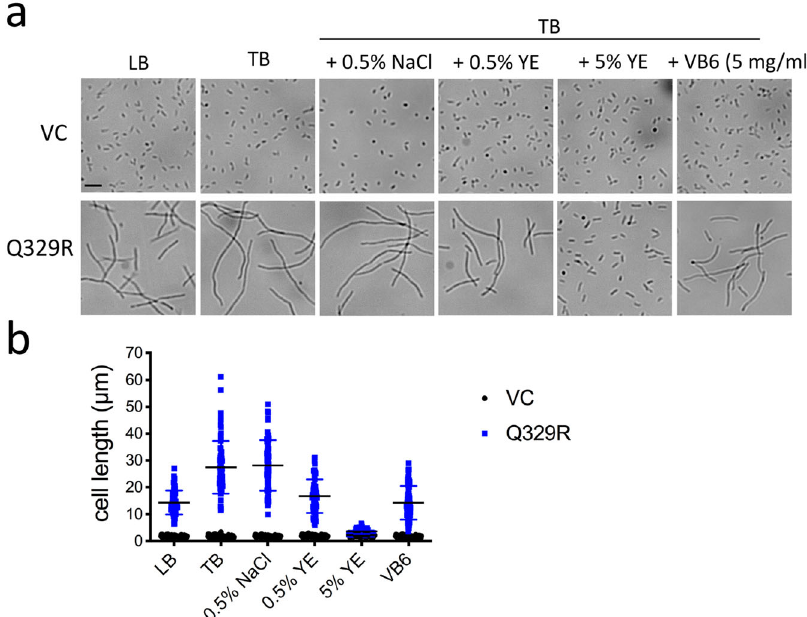
Fig. 7 Vitamin B6 (pyridoxine) restricts cell fi lamentation of E. coli MG1655 induced by CapV Q329R . a Light microscopy pictures of E. coli MG1655 cell morphology and, b quanti fi cation of cell length in LB and TB medium supplemented with 0.5% NaCl, 0.5% YE, 5% YE, and VB6 (pyridoxine, 5 mg/ml), respectively. The quanti fi cation is based on results from at least three independent experiments with the assessment of 70 cells from each group. Bar, 5 µm. VC = pBAD28. Q329R = CapV Q329R cloned in